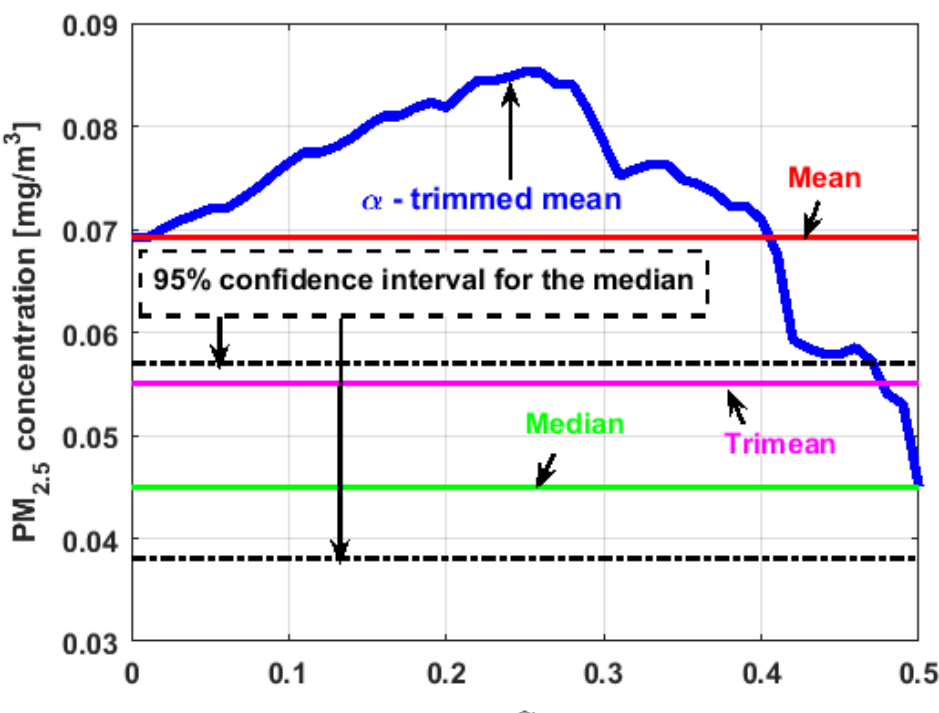
Figure 21. 𝛼 -trimmed mean of 𝑌 2 . Figure 21. α -trimmed mean of Y 2 .